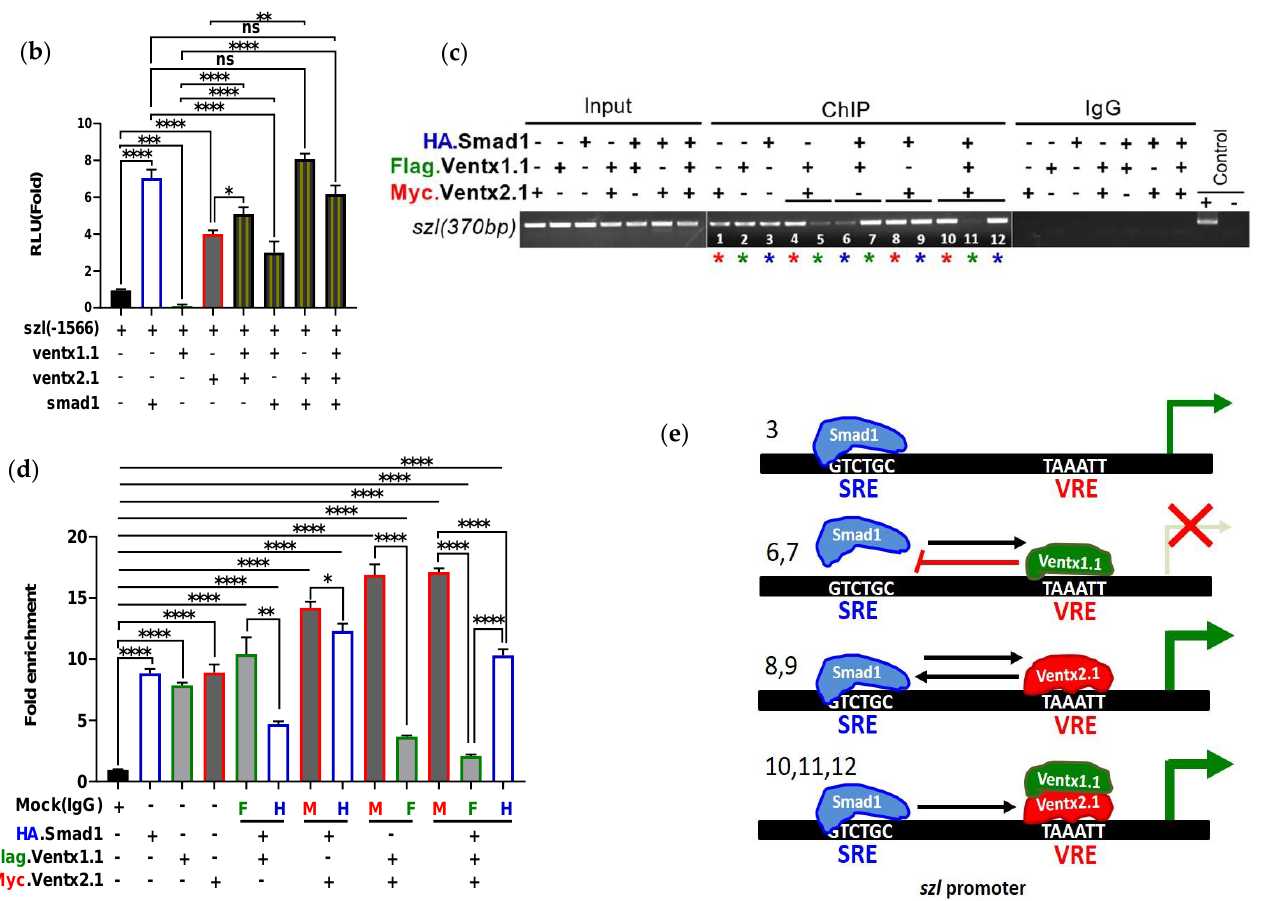
Figure 5. Smad1 enhances Ventx2.1-mediated szl activation and rescues Ventx1.1 mediated szl suppression. ( a ) Embryos were injected with smad1 , ventx1.1 and ventx2.1 mRNAs individually and in different combinations. Animal cap explants (10 AC/sample) were dissected at stage eight and quantitative RT-PCR of ventral specific marker genes including szl at gastrula stage were analyzed. V1.1 = Ventx1.1, V2.1 = Ventx2.1 ( b ) Szl(-1566) promoter construct were injected with smad1 , ventx1.1 and ventx2.1 mRNA alone and possible combinations and reporter gene activities were analyzed. ( c ) Xenopus leavis embryos (300 embryos/sample) were injected with ha.smad1 , 3flag.ventx1.1 , myc.ventx2.1 mRNAs alone and their possible combinations (0.5 ng/embryo each) and cultured to the gastrula stage. ChIP-PCR analysis using specific primers for the szl promoter region having the VRE site was performed. The asterisks of different colors indicate the difference of antibodies used for ChIP; red ( * ) for Myc.Ventx2.1, green ( * ) for Flag.Ventx1.1 and blue ( * ) for HA.Smad1. ( d ) Quantitative PCR analysis was performed with fold enrichment method and the experiment was repeated three times. ( a , b , d ) p ≤ 0.05 for *, p ≤ 0.01 for **, p ≤ 0.001 for ***, p ≤ 0.0001 for ****, ns (non-significant) were the assignments for significance. ( e ) A model of Smad1 and Ventx1.1/2.1 alone and in combinations mediated regulation of szl transcription. The numbers indicate the number of lane shown on ( c ), indicating that each schematic model diagram is related with and based on the result(s) of lane(s) shown on ( c